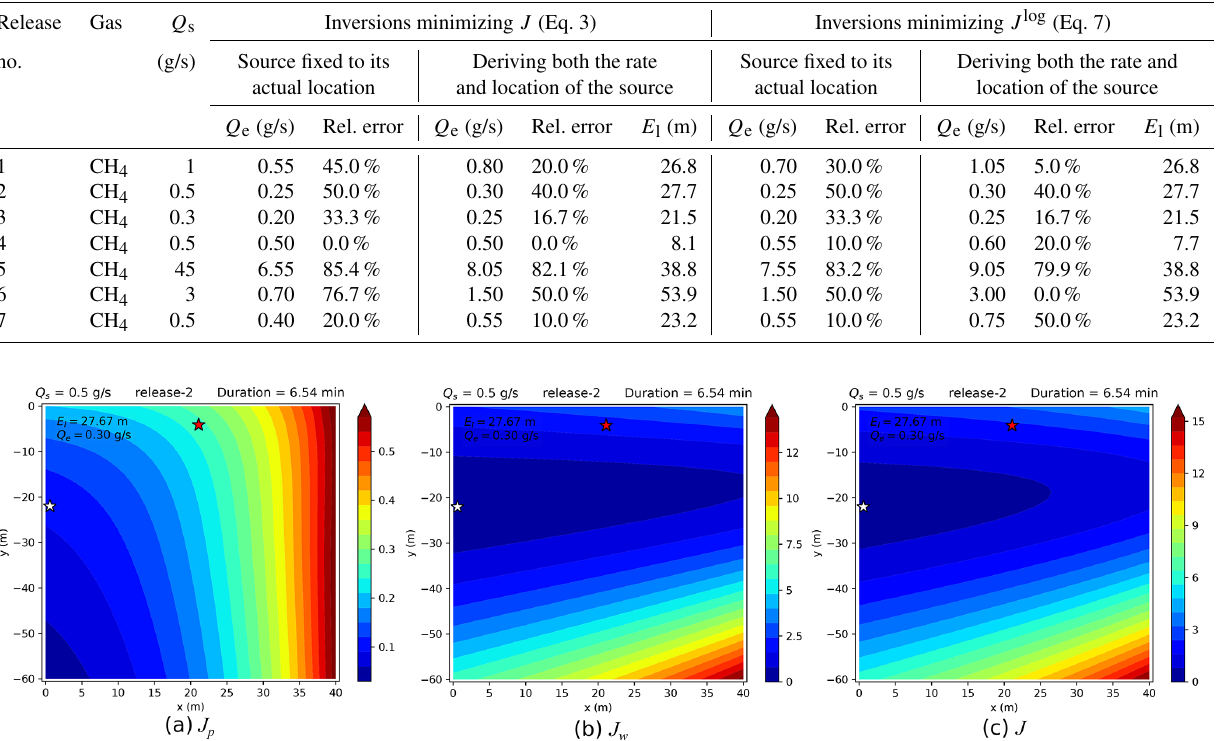
Figure 3. Contour plots of (a) J p , (b) J w , and (c) J when fixing the release rate to its inverted value Q e for release no. 2. Red and white stars respectively show the actual and inverted source